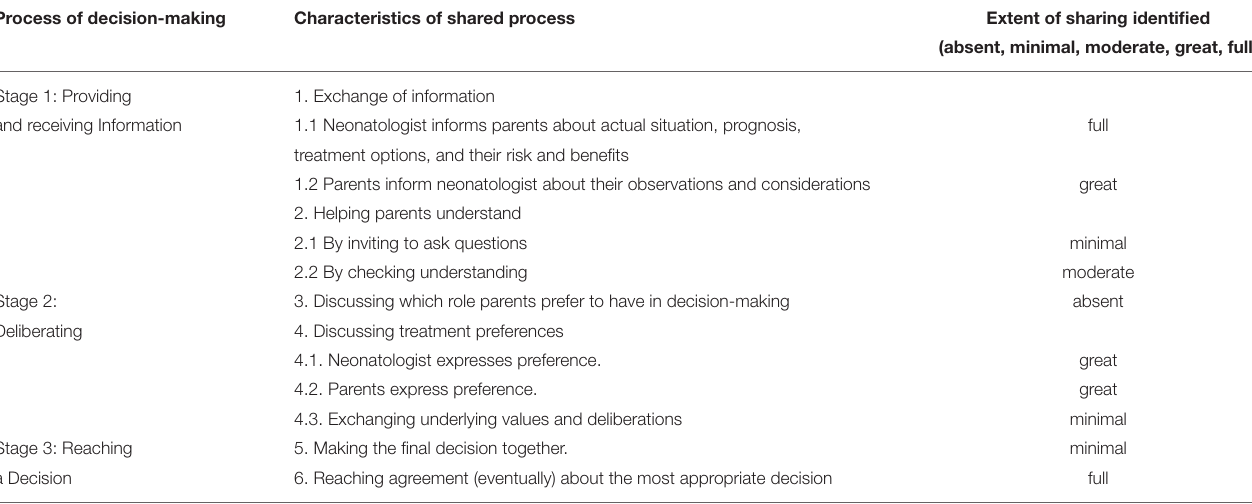
TABLE 6 | Extent of sharing. Process of decision-making Characteristics of shared